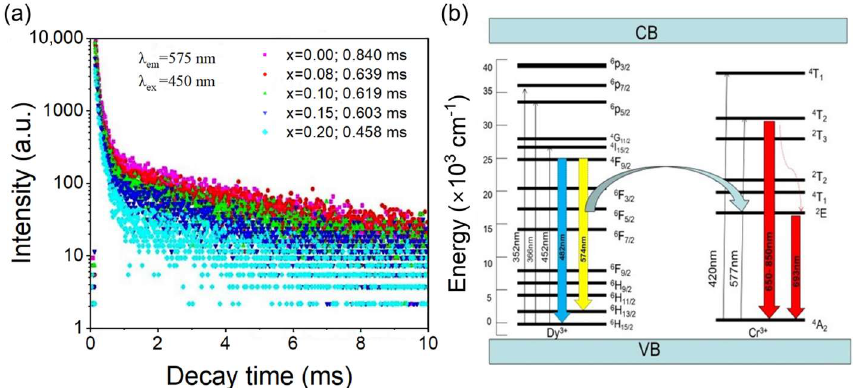
Figure 5. ( a ) Decay curves of Dy 3+ emission in GAGG: x Cr 3+ , 0.01Dy 3+ ; ( b ) energy levels, electron transitions and energy transfer schematic diagram of Dy 3+ and Cr 3+ in GAGG.